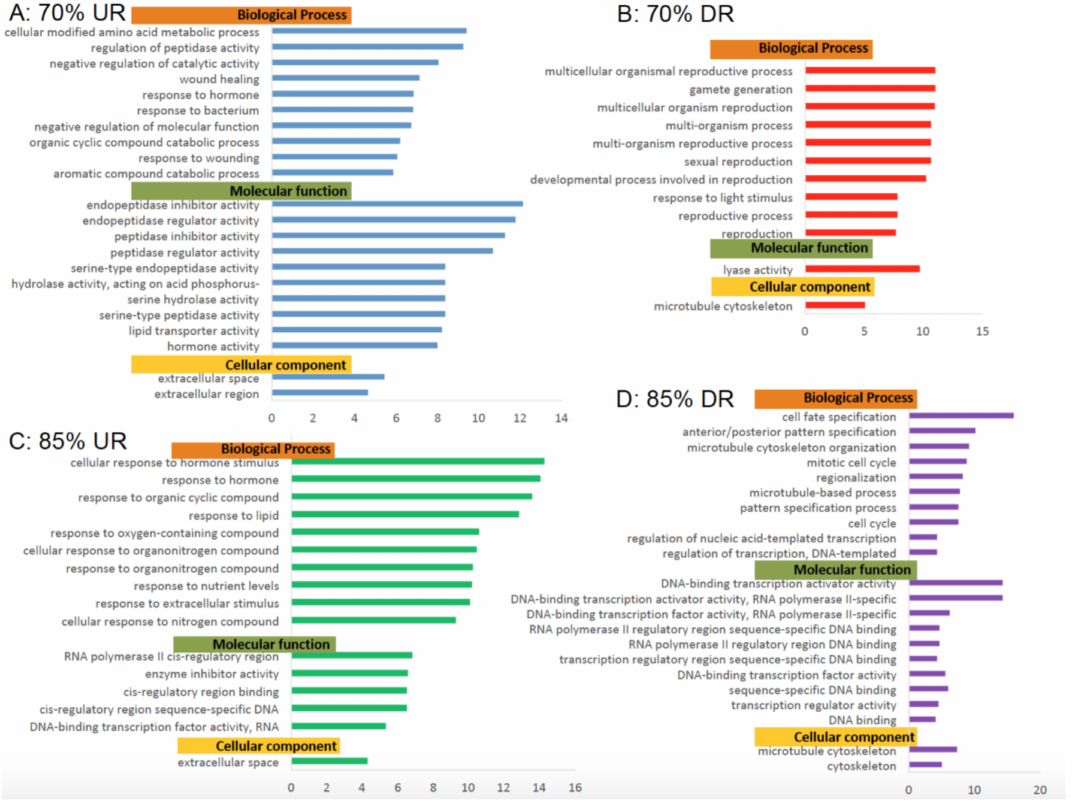
Figure 5. Gene Ontology Analyses of Biological Processes, Molecular Functions and Cellular components. Significantly (false discovery rate (FDR) < 0.05) enriched Gene Ontology (GO) terms from complete analysis for 70% and 85% feeding groups differentially shared genes grouped by biological process, molecular function, and cellular component. GO terms containing a minimum 100 reference genes and a fold change ≥ 4 or ≤ 4 are represented. ( A ) 70% upregulated genes; ( B ) 70% downregulated genes; ( C ) 85% upregulated genes; and ( D ) 85% downregulated